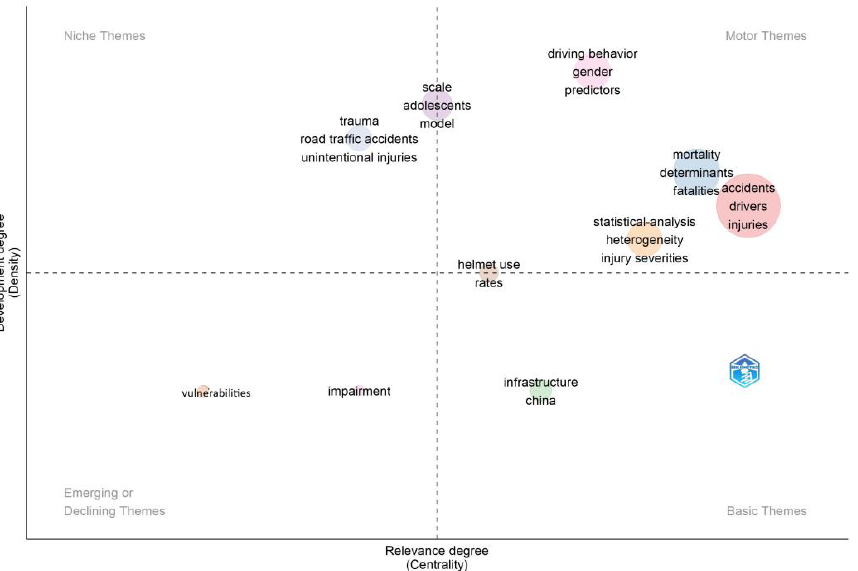
Figure 10. Thematic map of research on driver behaviour and traffic safety in Africa. Source: Author’s own, based on Web of Science search. (Walktrap Clustering Algorithm, Minimum Cluster Frequency 5/1000 documents, 250 keywords.)